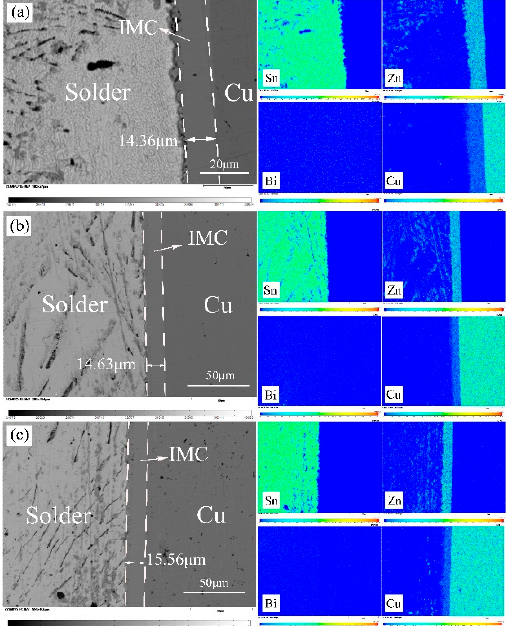
Figure 10. EPMA images and map analyses of the interface of Sn-9Zn-xBi/Cu joints: ( a ) x = 0; ( b ) x = 1; ( c ) x = 2.